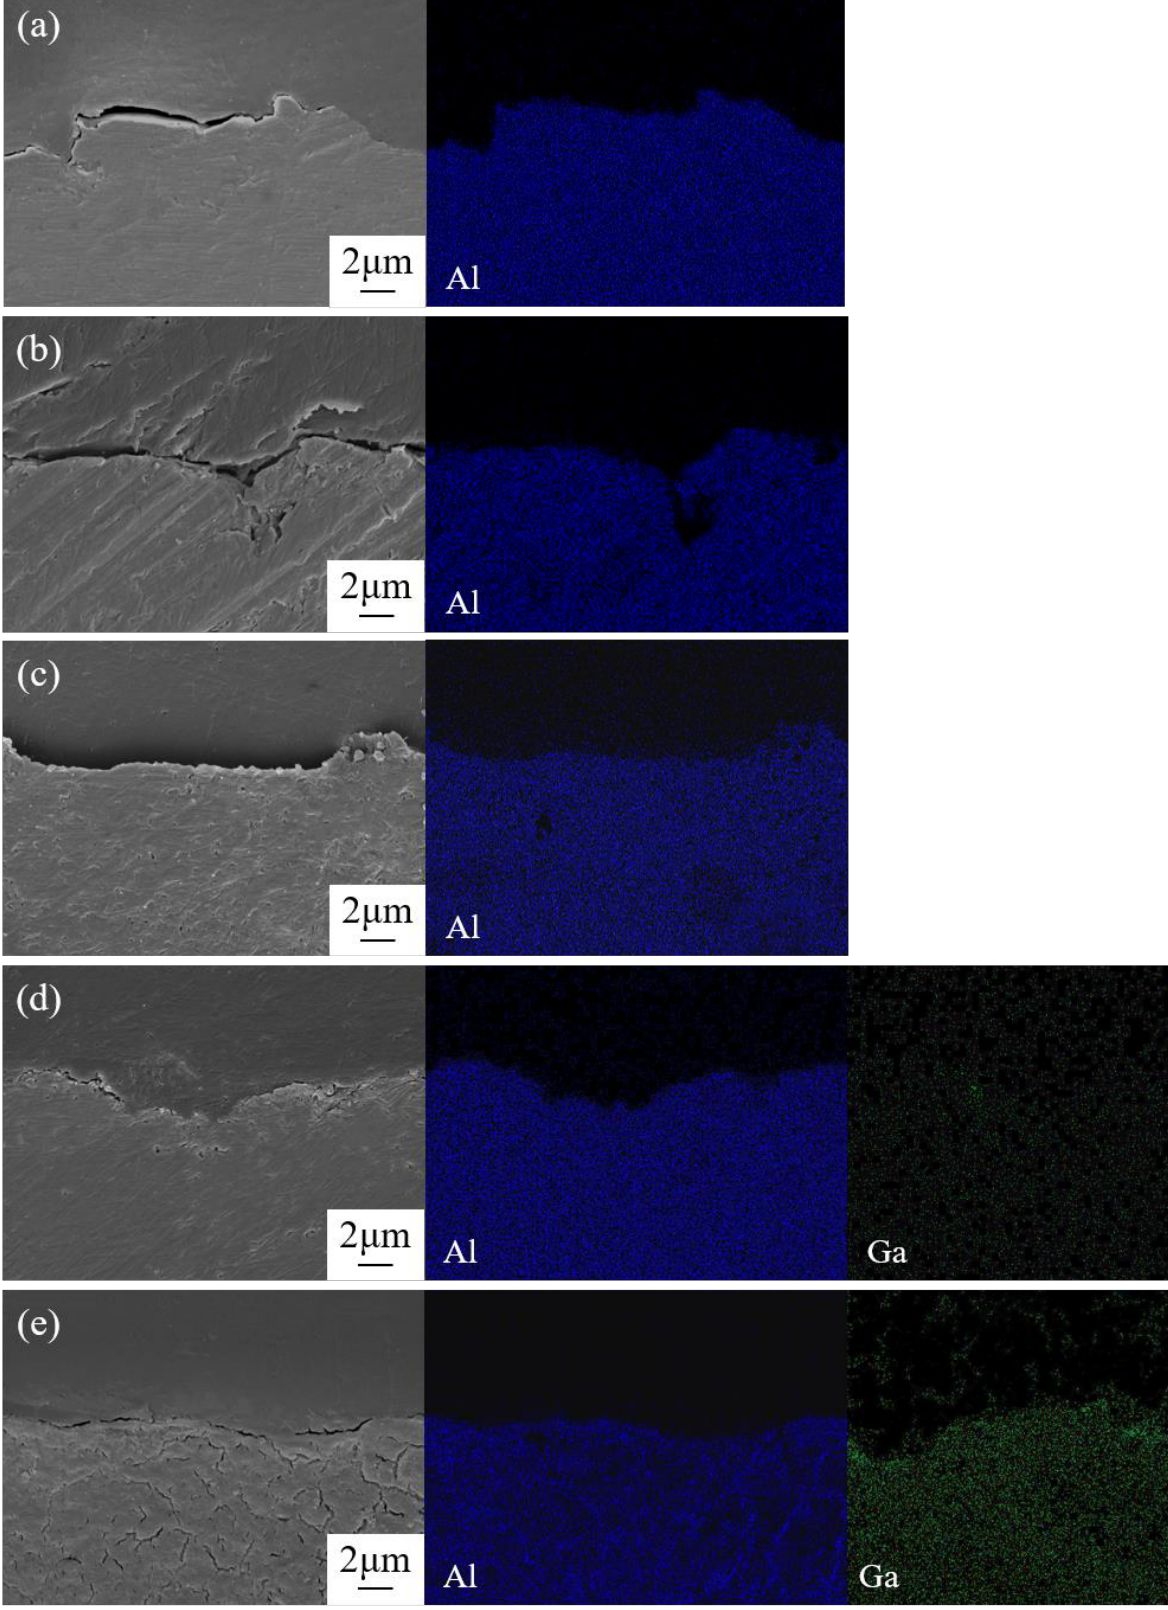
Figure 6. Cross-sectional images and the corresponding elemental distribution of Al anode after discharge at 10 mA cm −2 for 2 h in 2 M NaCl electrolyte ( a ) without and with different contents of GaCl 3 : ( b ) 0.05 M, ( c ) 0.1 M, ( d ) 0.15 M, and ( e ) 2 M.